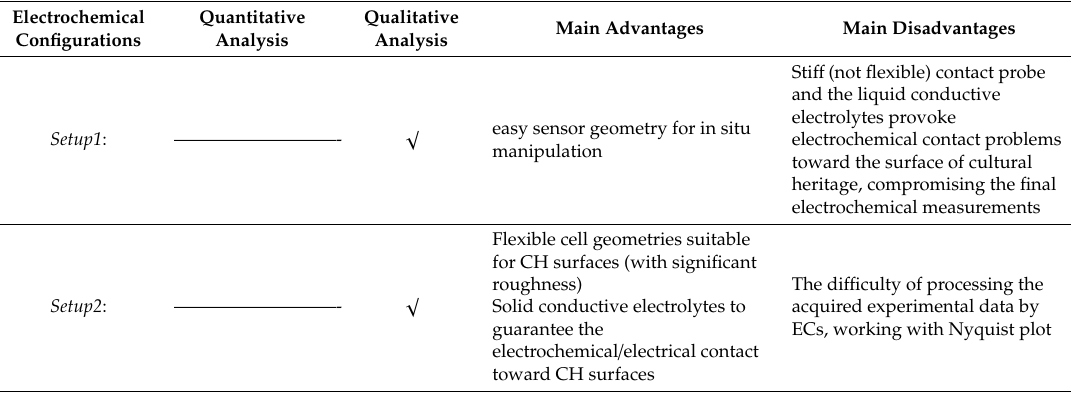
Table 2. Main characteristics and analytical performance of Setup 1 and Setup 2 proposed in the first section of the